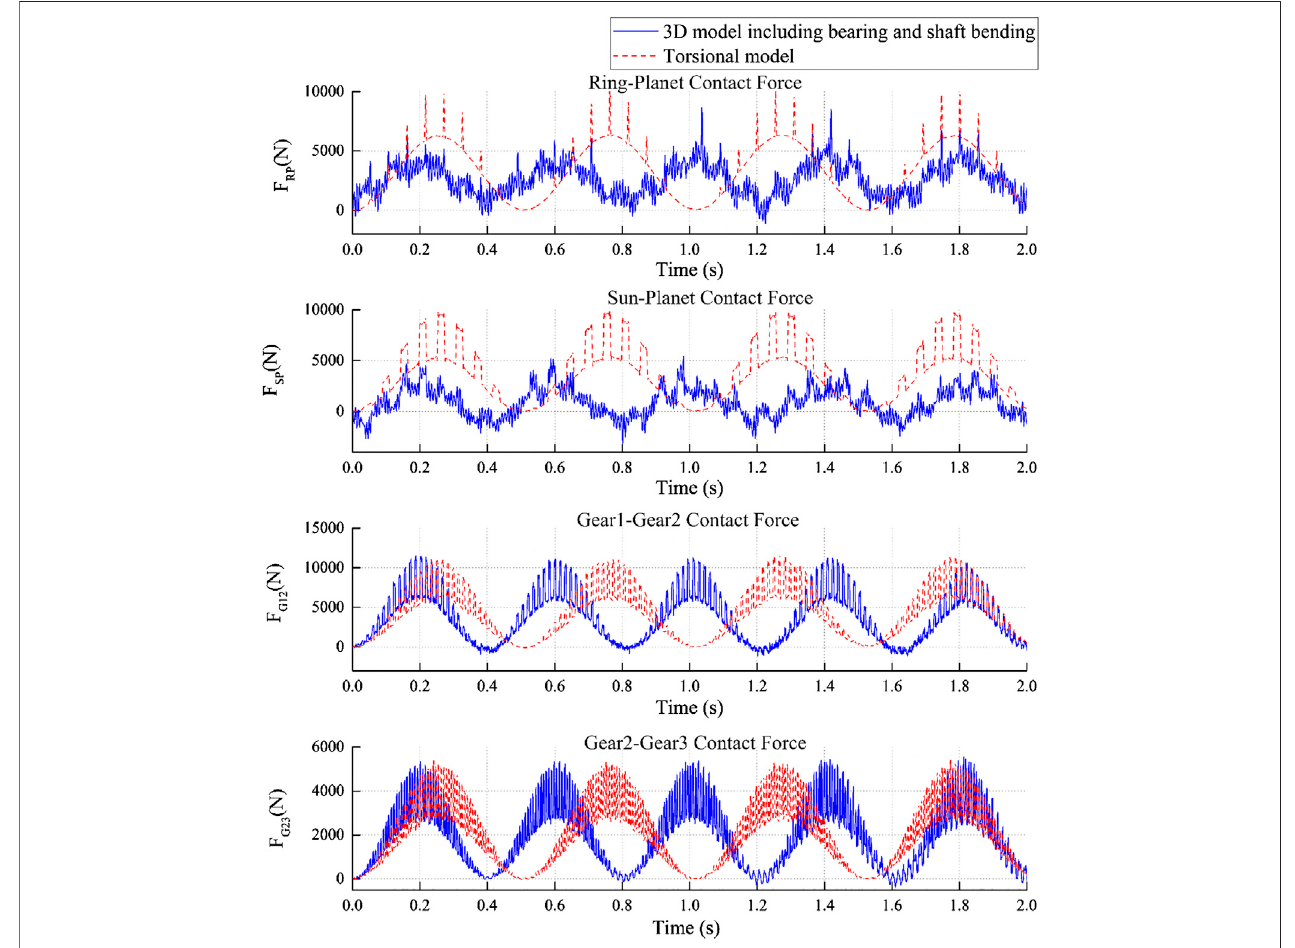
FIGURE 7 | Gear mesh contact force comparison between the torsional model and the 3D model.